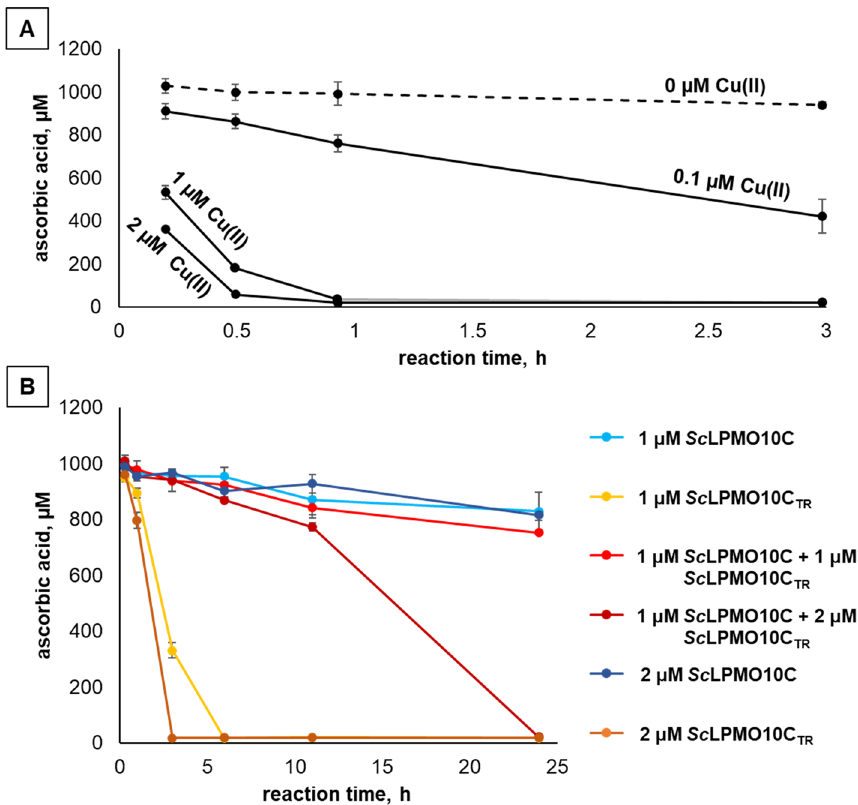
Figure 4. Ascorbic acid consumption in reactions containing Cu(II)SO 4 (panel A ) or LPMOs (panel B ). The reactions were carried out at 30 °C in 50 mM sodium phosphate buffer, pH 6.0, supplied with 1% (w/v) Avicel, and were initiated by the addition of 1 mM ascorbic acid at t = 0. The reductant concentration was determined by UV spectroscopy immediately after removing the insoluble LPMO substrate by filtration. Note that the reductant depletion curves in panel B were obtained using the same samples as shown in Fig. 3. Error bars indicate standard deviations between